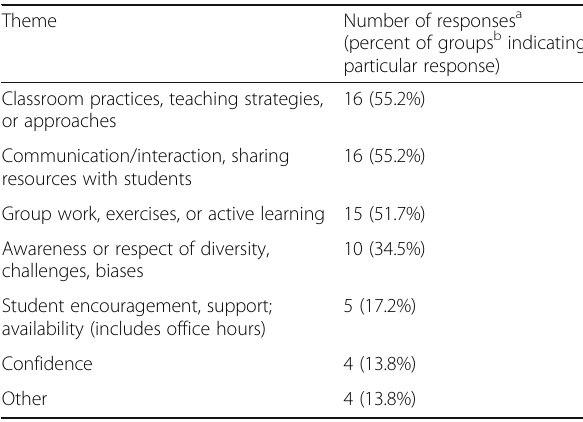
Table 6 Themes from qualitative responses to questions asked during follow-up luncheon with workshop participants